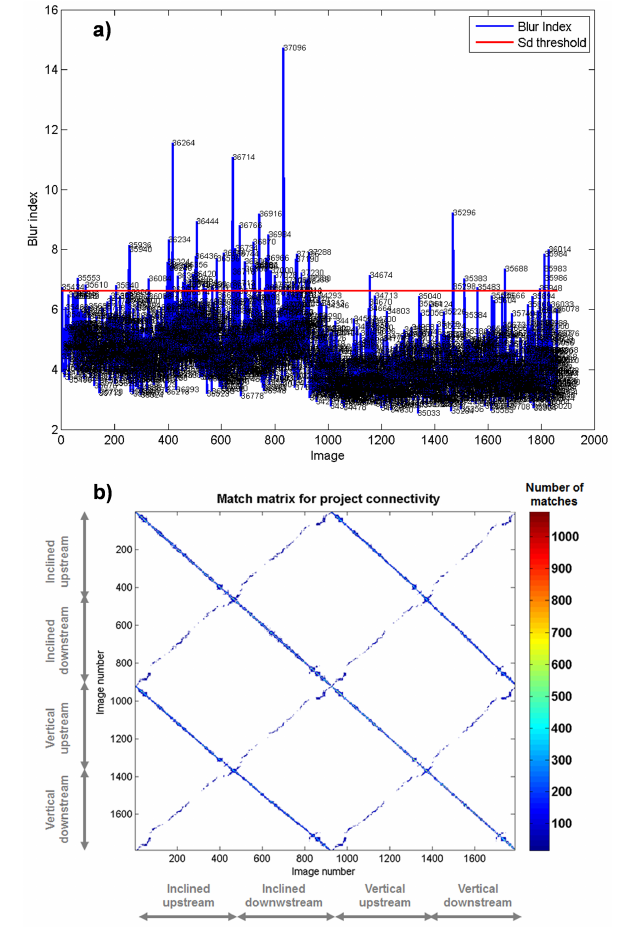
Figure 5. SF3M results of the pre-processing and project analysis stages for the gully branch 2: (a) blur index for the ∼ 1800 im- age set with image number label. Those images outside the upper 2 standard deviations interval (red line) were discarded; (b) matrix of matches with indication of the camera and direction in the image collection (in grey). The matrix of matches is symmetrical. Matches in the diagonal correspond to image sets only connected in the linear direction.